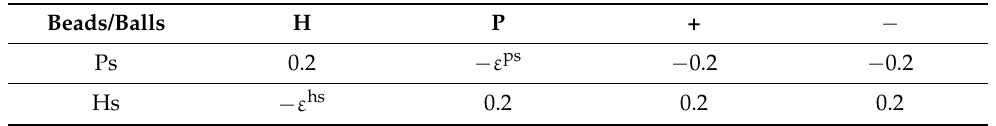
Table 2. Interaction energies between the polypeptide chain (H, P, +, and − ) and beads of hydrophilic (Ps) and hydrophobic (Hs) surfaces. ε ps and ε hs can be tuned in simulation.